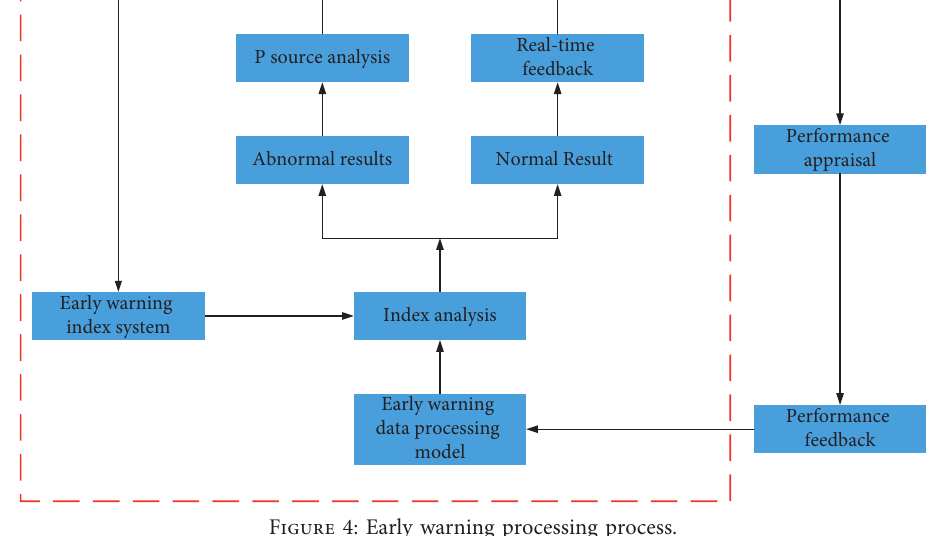
Figure 4: Early warning processing process.